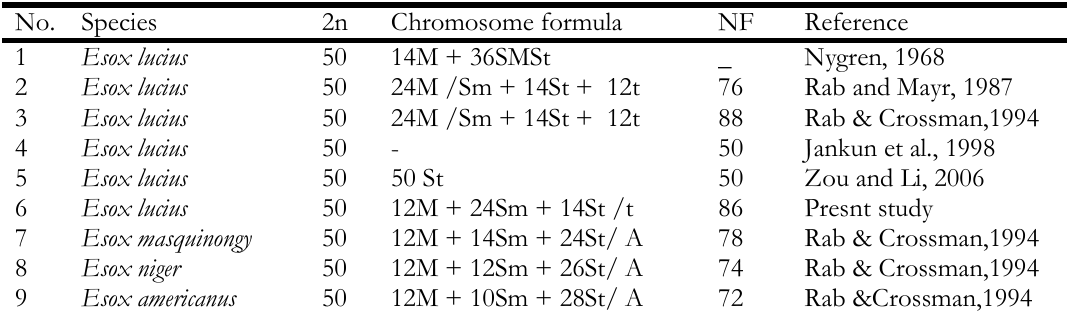
T ABLE 1 . Chromosome formula, chromosome number (2n) and chromosome arms in different species belonging to the genus